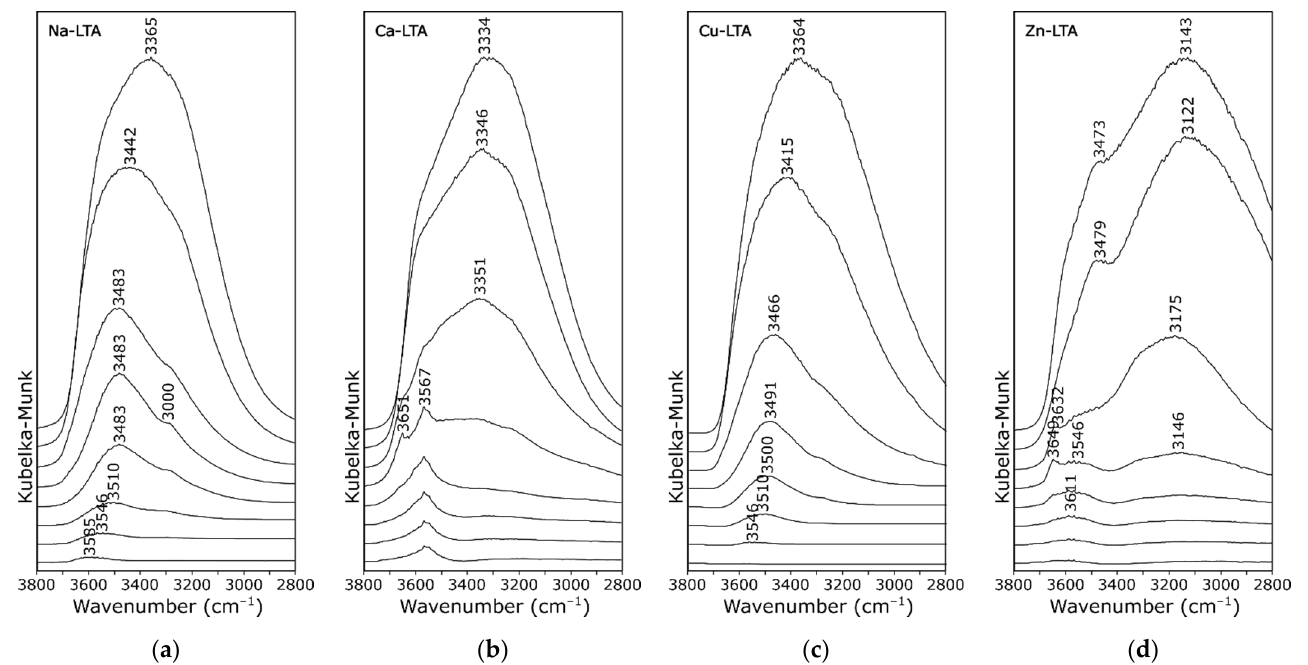
Figure 4. DRIFT spectra of zeolite A recorded at 50 °C intervals (from 50 to 400 °C, respectively, from top to bottom): ( a ) Na-A; ( b ) Ca-A; ( c ) Cu-A; and ( d ) Zn-A. Changes in the spectral envelope to about 400 ◦ C were mainly related to water loss (Figure 4). The zeolite dehydration took place up to the temperature of about 180 ◦ C, hence, the intensity of the band with a large FWHM (full width at half maximum) disappeared